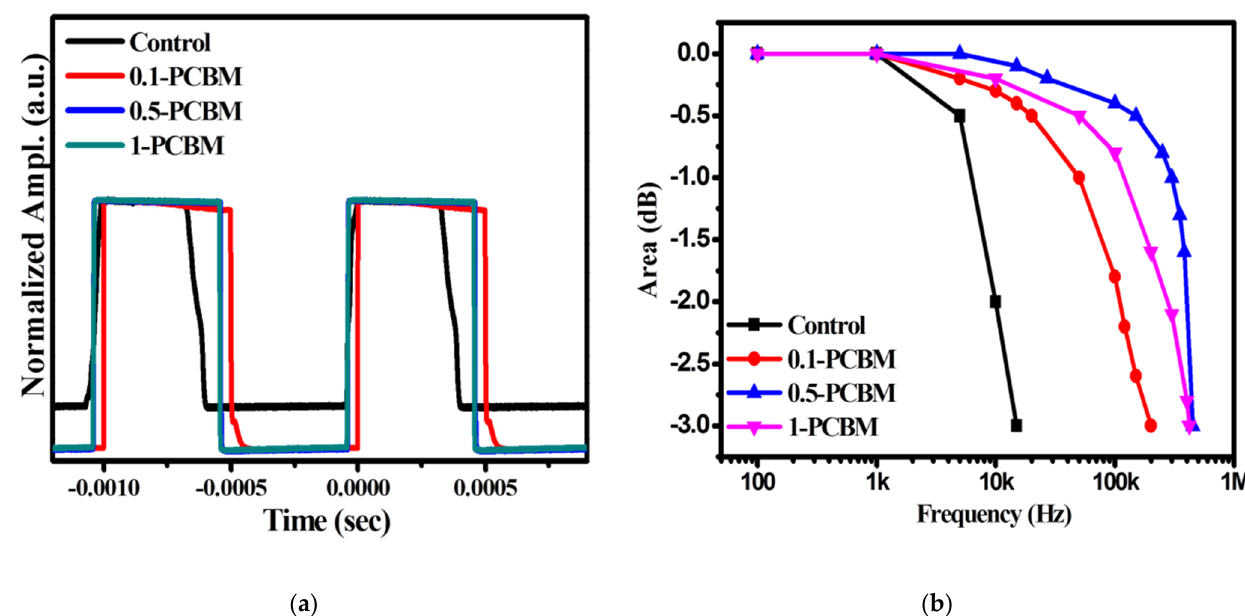
Figure 6. ( a ) Rise and fall times and ( b ) cut − o ff frequencies of the